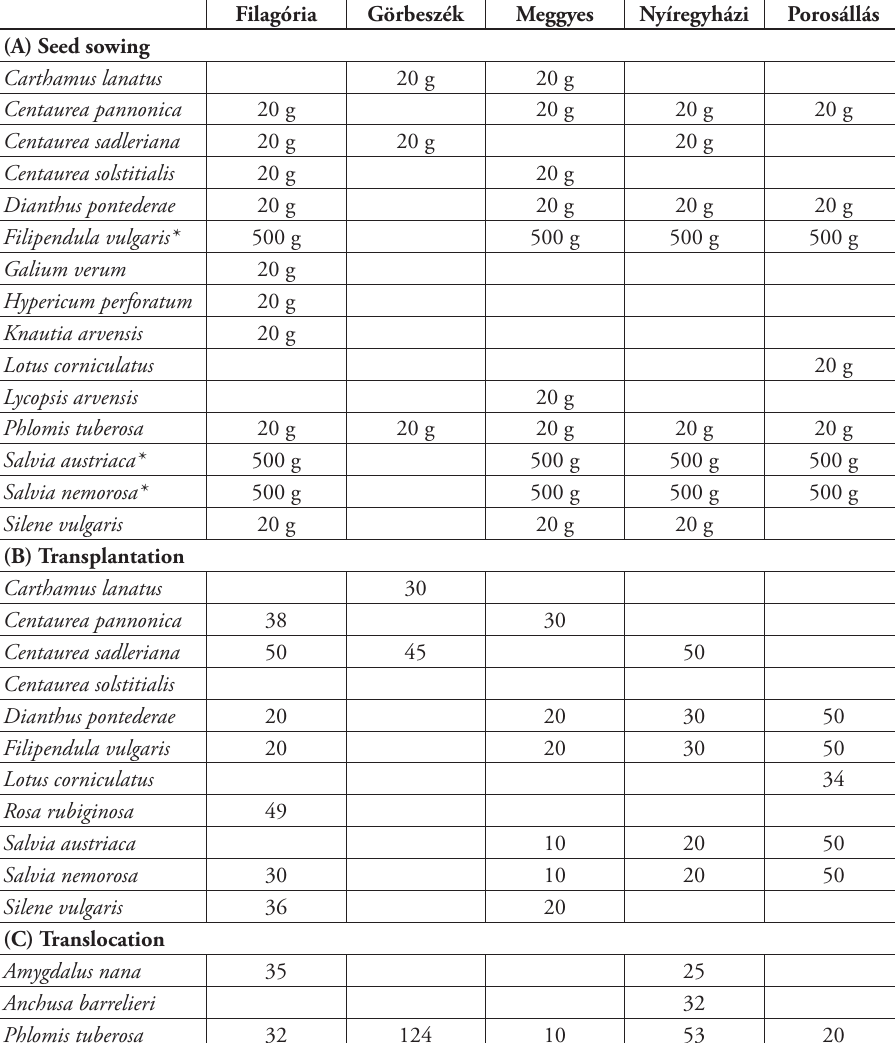
Table 2. List of species introduced on the five kurgans. (A) Sown species and the amount of sown seeds (g), (B) Species list and number of greenhouse-grown transplants and (C) Species list and number of individuals translocated from threatened natural populations. Matrix species are marked with an asterisk. Filagória Görbeszék Meggyes Nyíregyházi